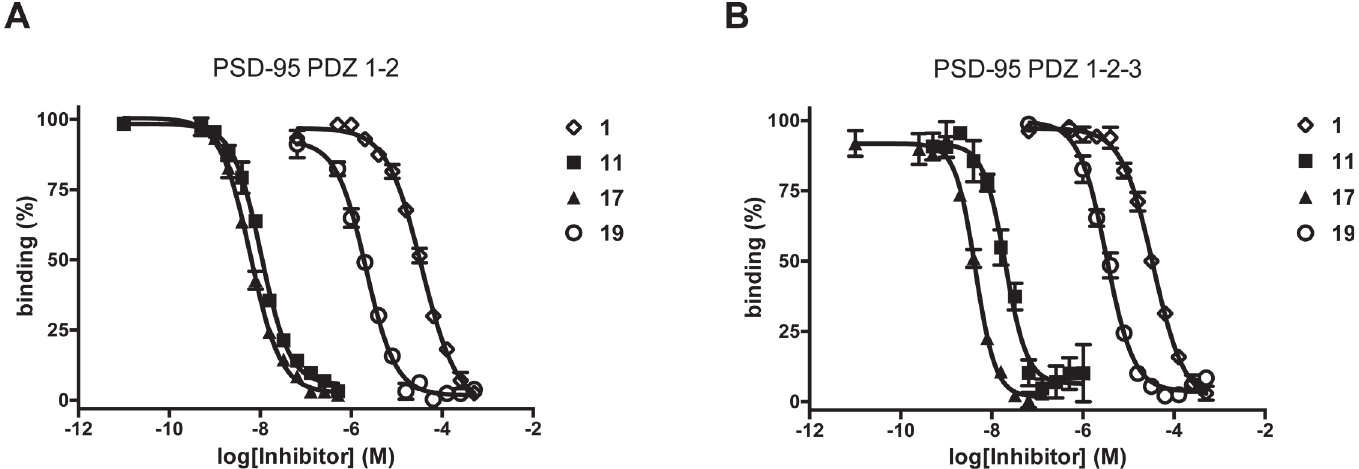
Fig 4. FP binding curves of 1, 11, 17 and 19 for PSD-95 PDZ1-2 (A) and PSD-95 PDZ1-2-3 (B). Data plotted as mean ± SEM, n (cid:2) 3.